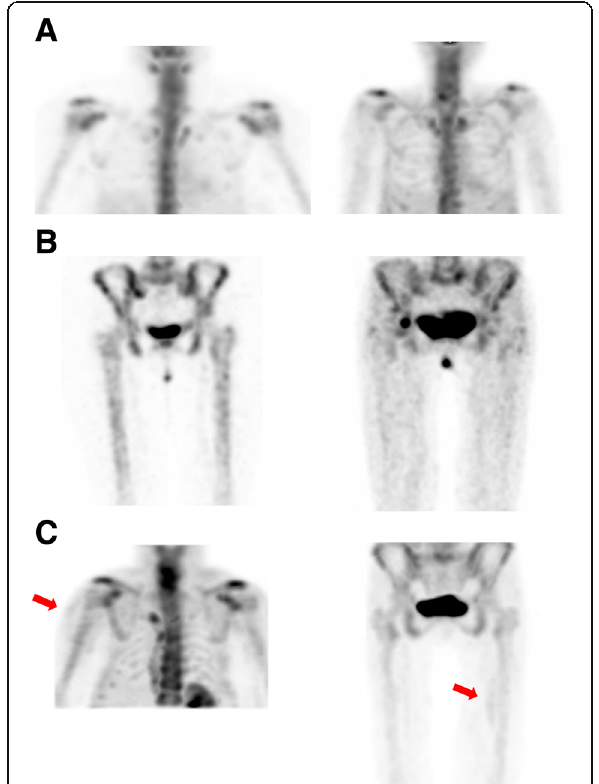
Fig. 2 Maximum intensity projection images showing the distribution of 99m Tc-PYP. a Upper body of a control person (left) and a patient with idiopathic inflammatory myopathy (right). b Lower body of a control person (left) and a patient with idiopathic inflammatory myopathy (right). In the control person, bones are clearly delineated, whereas in the patient, the muscular and the skeletal uptake are confluent. c Examples of an irregular 99m Tc-PYP uptake leading to hot spots in the muscles of a patient with idiopathic inflammatory myopathy. Hot spots are marked with red